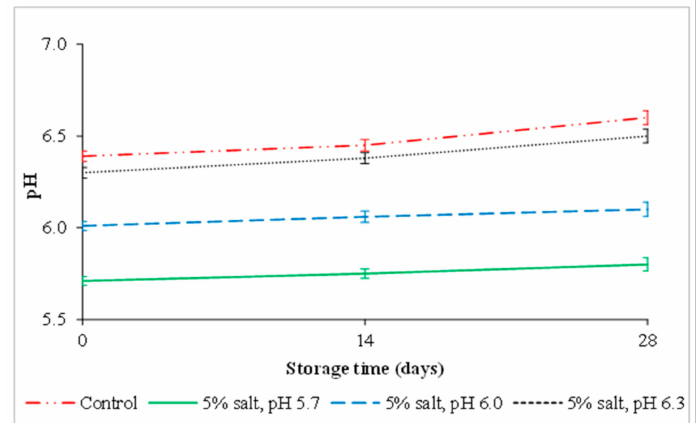
Figure 2. The effect of treatment on the pH of frozen-thawed liquid egg yolk. Data are presented with mean ± standard